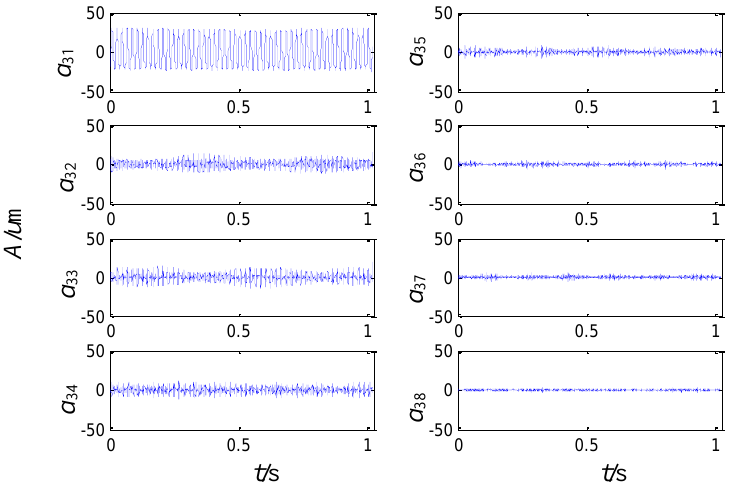
Figure 17. Signal analysis by the second generation wavelet package in level 3 after